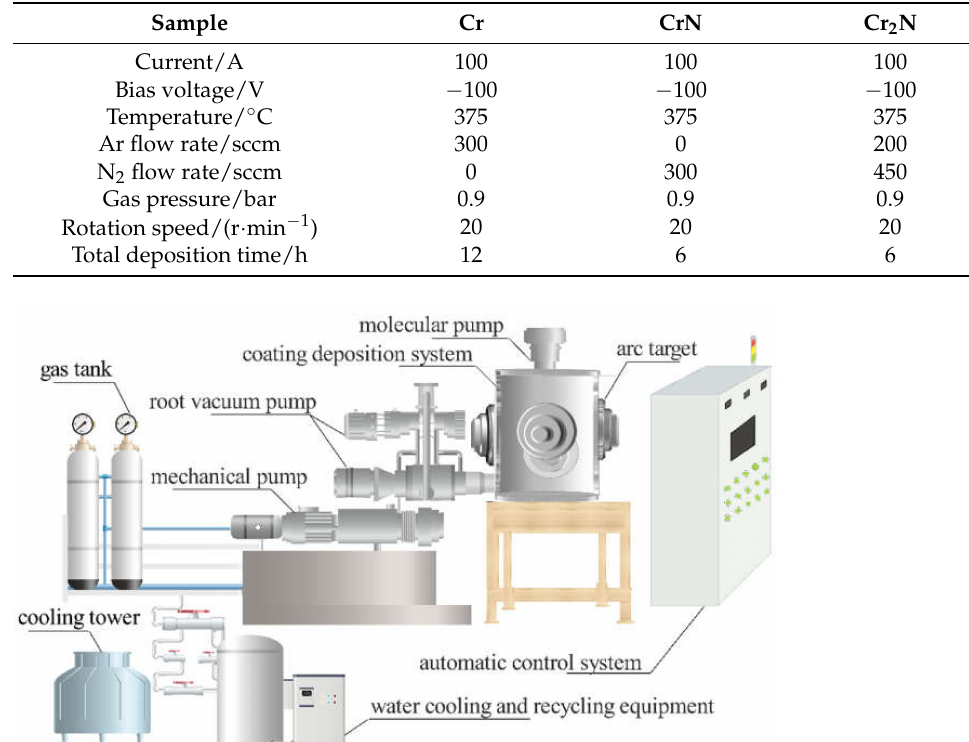
Table 2. Deposition parameters of the Cr-N x coatings using multi-arc ion plating.